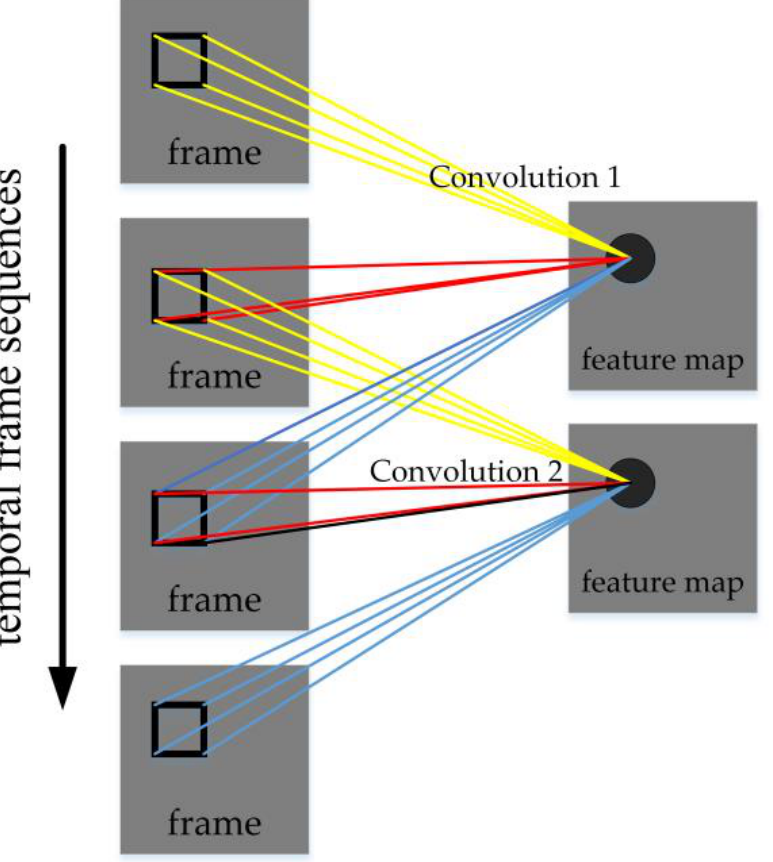
Figure 21. Three-dimensional Convolution. Every 3 adjacent feature maps are convolved to the next feature map, and move on in this style.